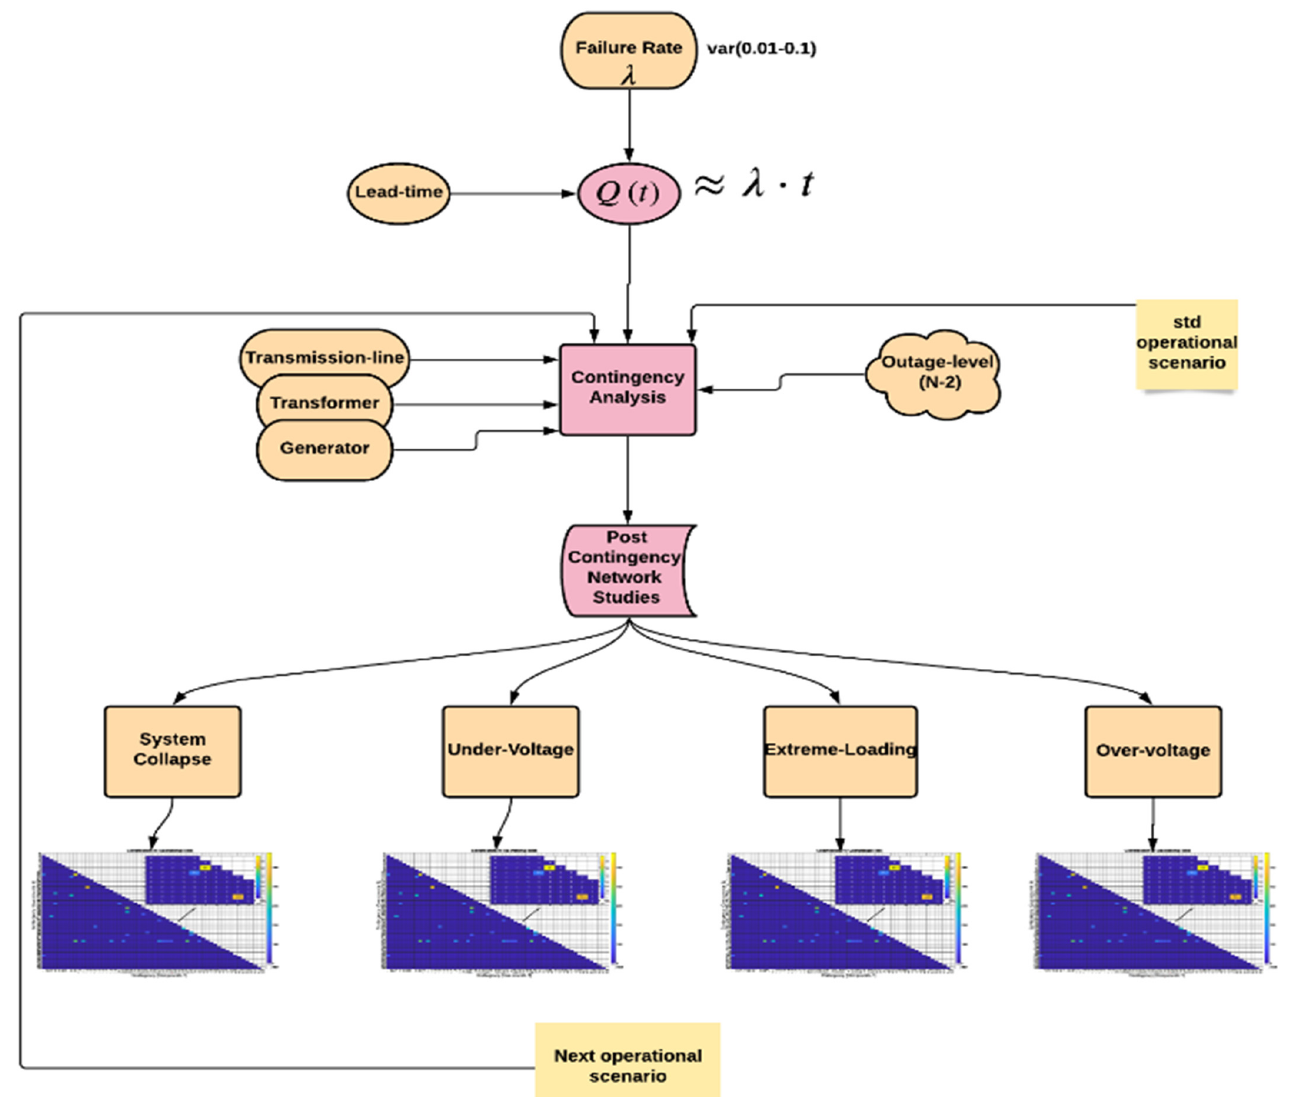
Figure 1. The procedural flow of operational risk under different operational scenarios.